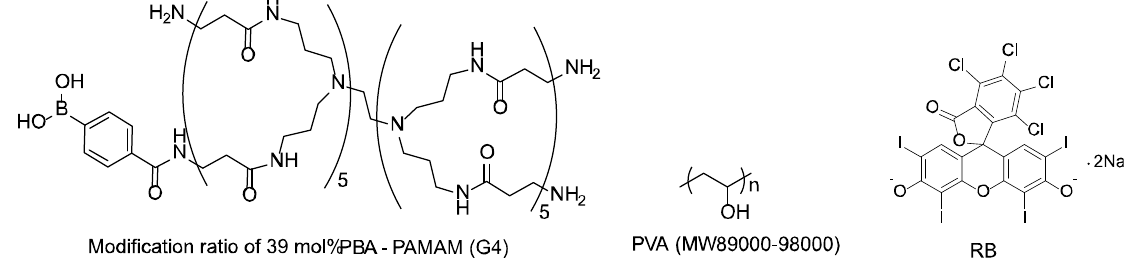
Figure 4. Chemical structures of PBA-PAMAM, PVA, and RB.